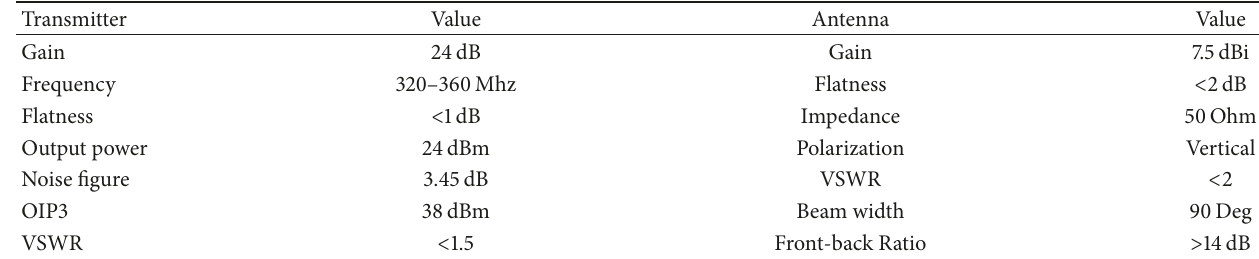
Table 1: Parameters of transmitter and antenna.